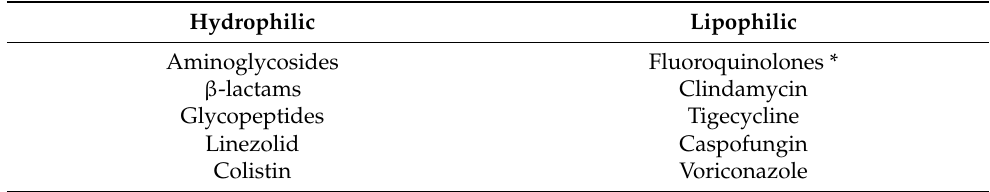
Table 1. Selected antibiotics are divided into hydrophilic and lipophilic. Hydrophilic Lipophilic Aminoglycosides Fluoroquinolones * β -lactams Clindamycin Glycopeptides Tigecycline Linezolid Caspofungin Colistin